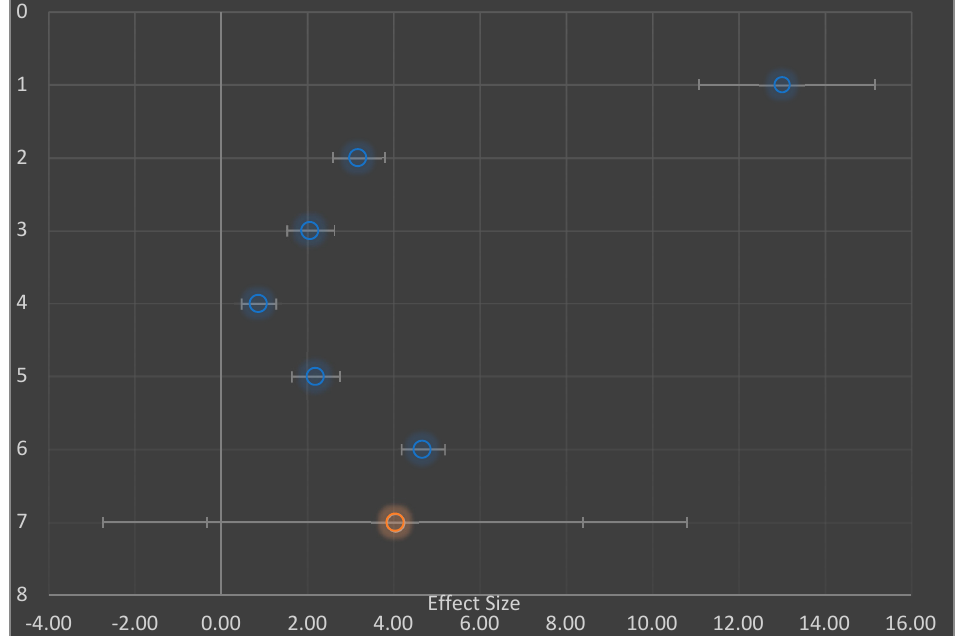
Figure 4. Forest Plot showing random effect meta-analysis of the mean difference in control of blood sugar level (mg/dL), based on diabetic intervention and negative diabetic control. Data for studies 1, 2, 3, and 4 are based primarily on control of blood sugar level whereas data for studies 5 and 6 are based on control of blood sugar level in sustained release-time.